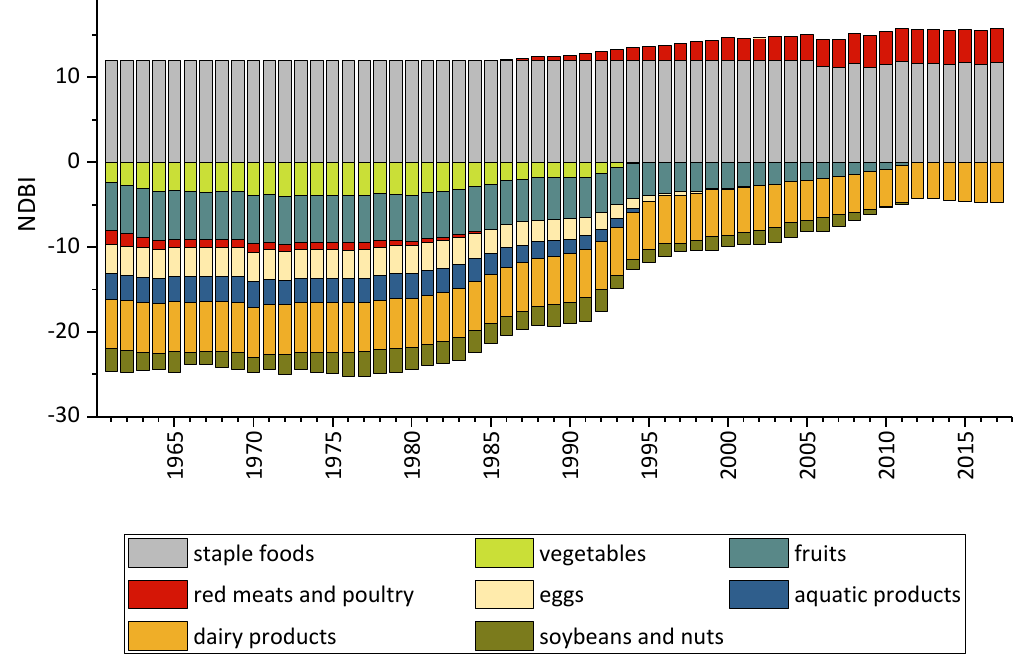
Figure 2. NDBI scores for each food group.